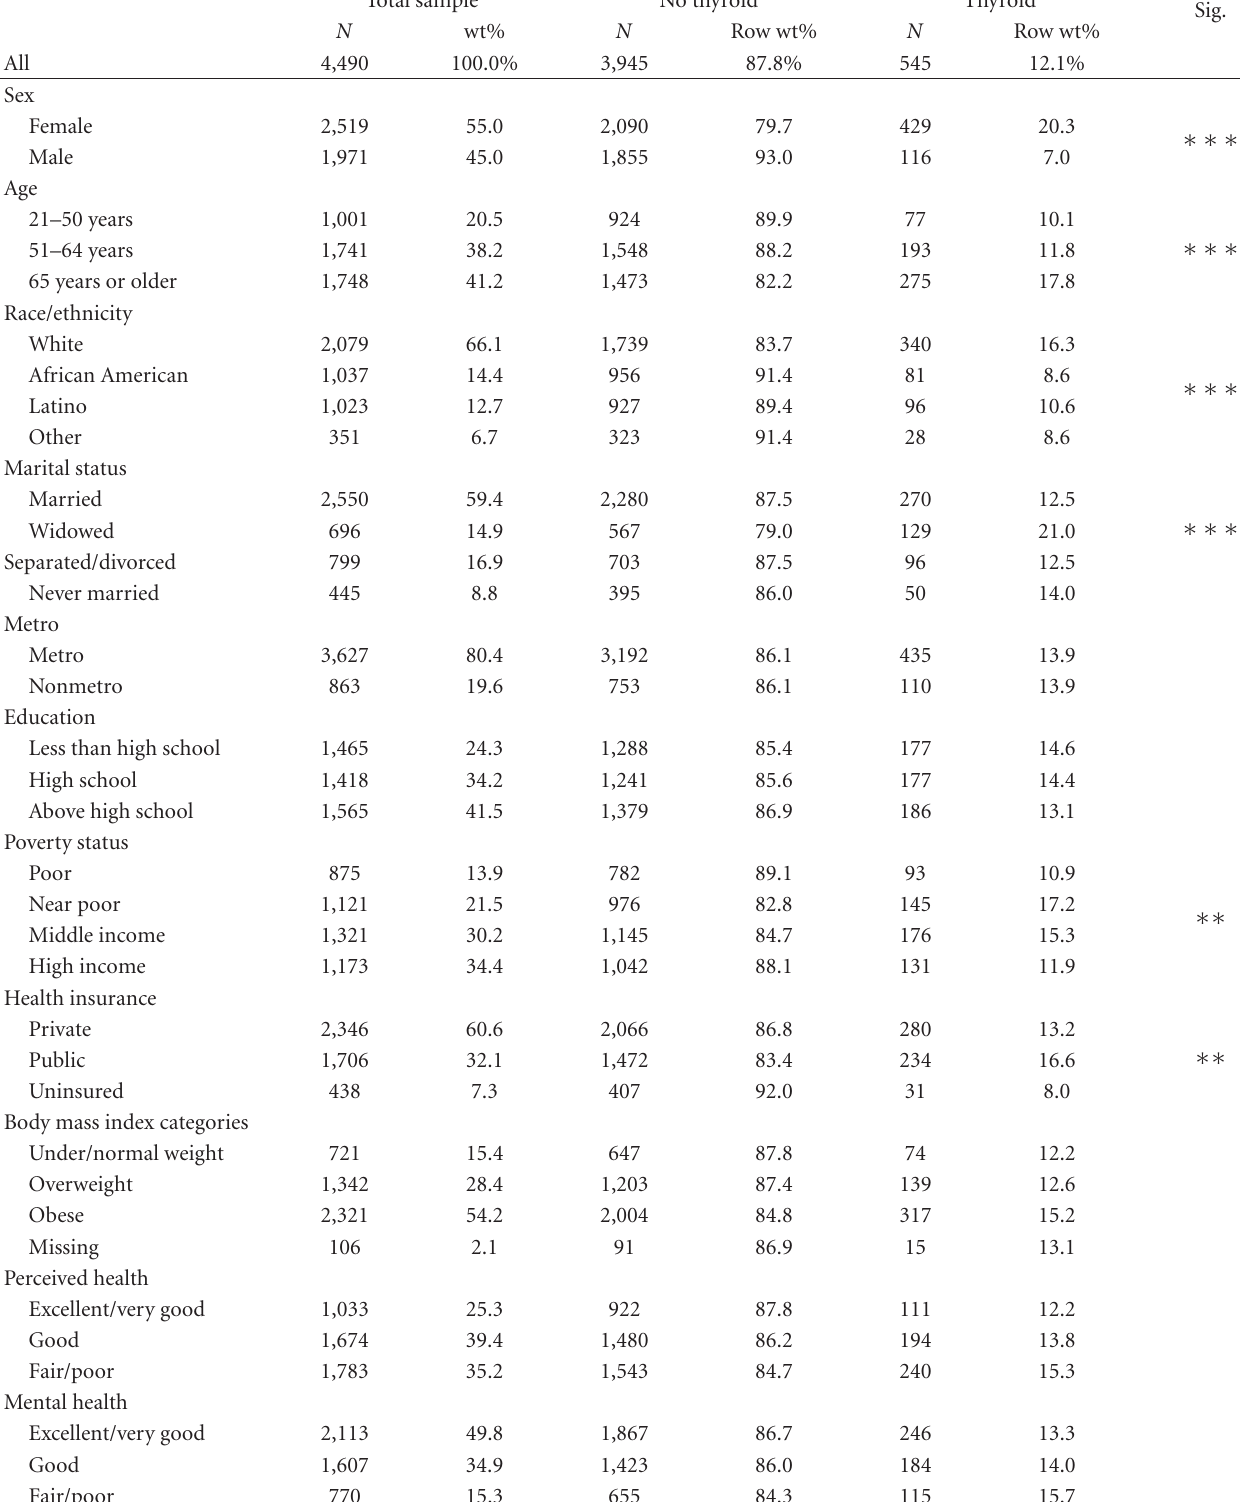
Table 1: Description of sample characteristics of individuals with diabetes by the presence of thyroid disorders from the Medical Expenditure Panel Survey, 2007 and